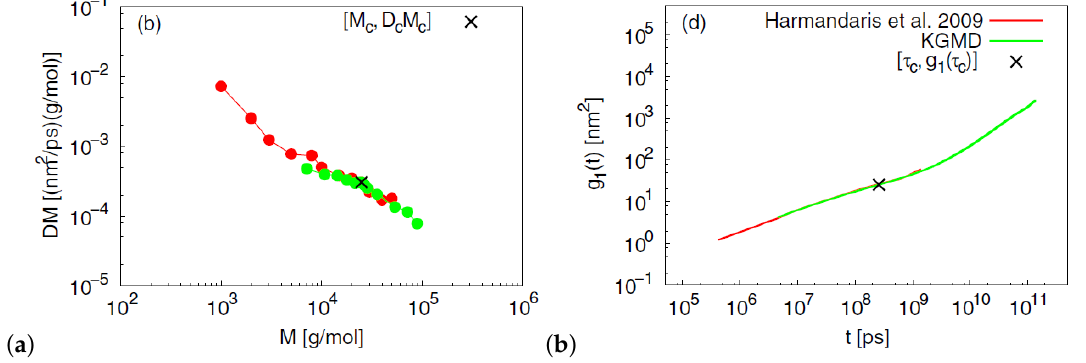
Figure 3. Results of mapping between multiscale MD of PS and Kremer-Grest MD (KGMD). ( a ) Diffusion coefficient times M versus molecular weight M , ( b ) mean square displacement, g 1 ( t ) , of central monomers for 50 kDa PS [77]. Reprinted from [77] with permission from Springer Nature. Regarding the PE melt, atomistic MD simulations were performed with a number of monomers from N = 78 to N =